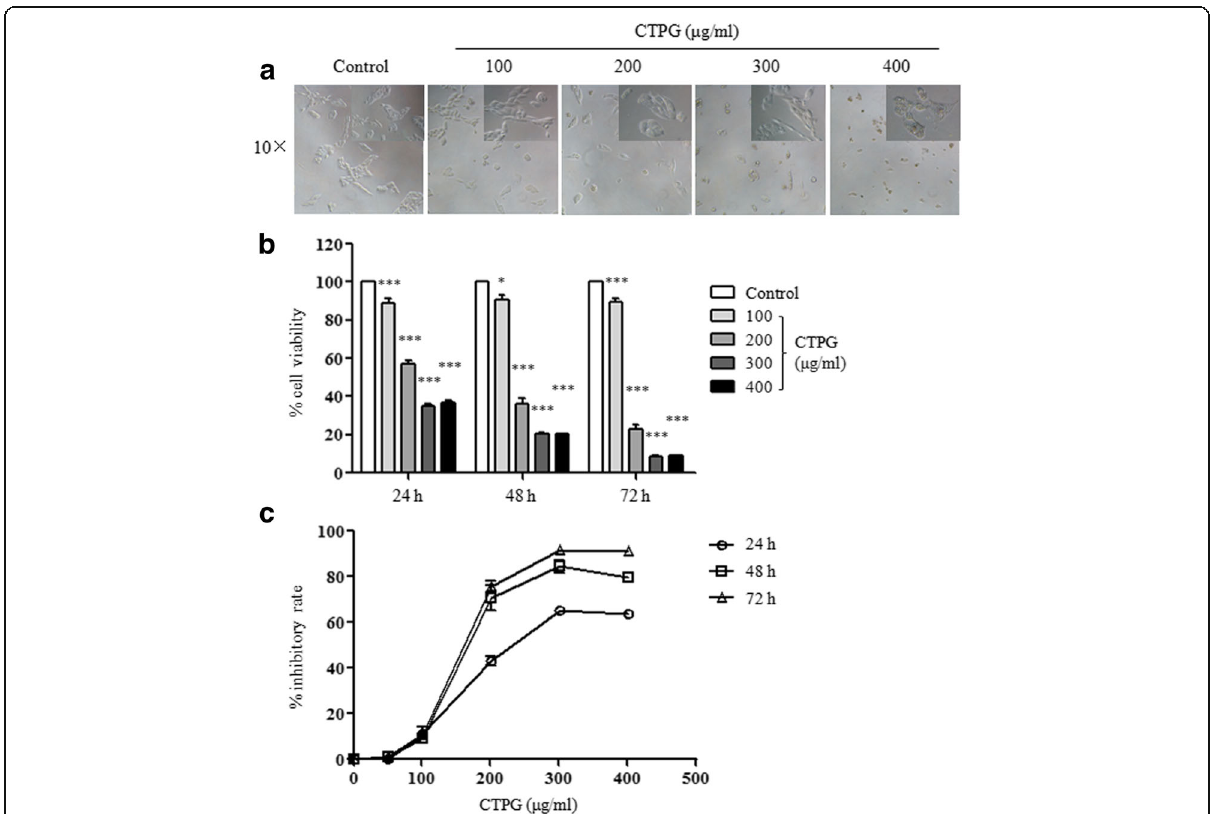
Fig. 1 The effect of CTPG on the growth of H22 cells. H22 cells were treated with different concentrations of CTPG. ( a ) After 24 h, the morphology of H22 cells was observed by inverted microscope. Inserted panels: 20 folds of magnification. ( b ) After 24, 48 and 72 h, cell viability was detected by MTT assay. ( c ) The inhibitory rate of CTPG. * p < 0.05; *** p < 0.001 compared to